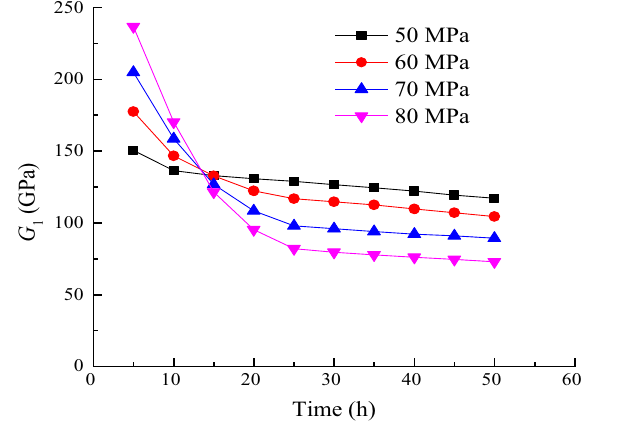
Figure 12. Duration of G 1 when σ 3 = 15 MPa.